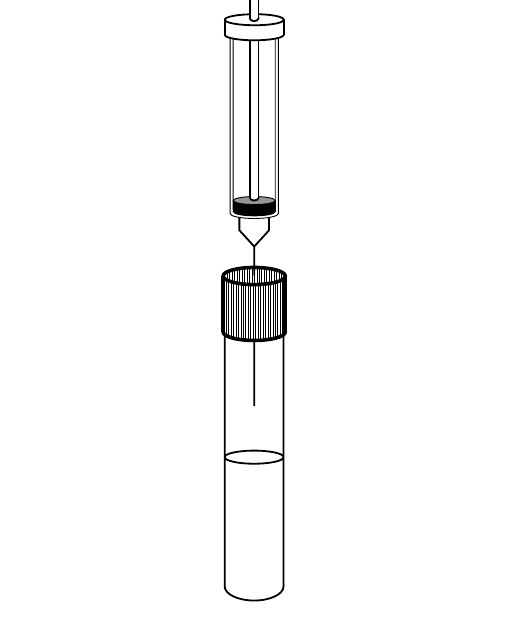
Figure 1. Disposition of the tube, syringe and needle used in the Bacterial VSC Production